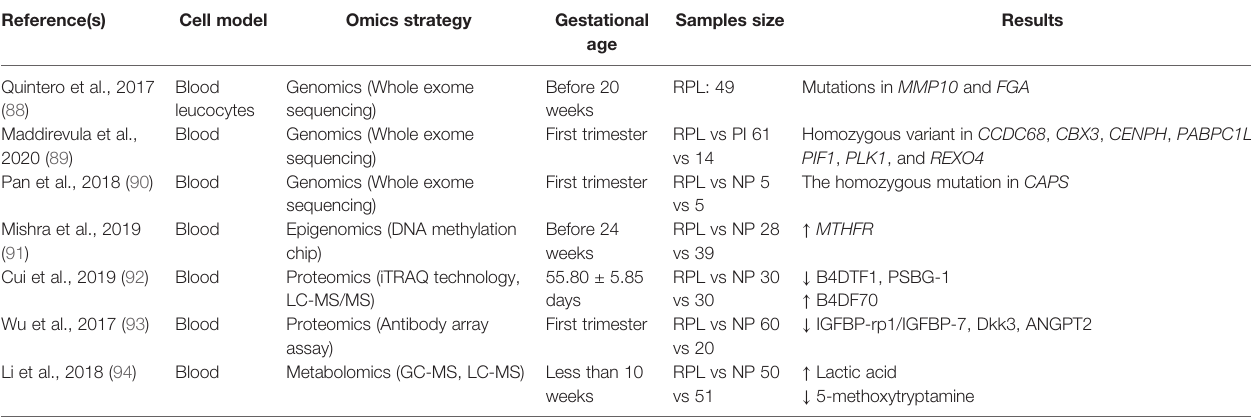
TABLE 3 | Omics studies on blood of recurrent pregnancy loss patients and